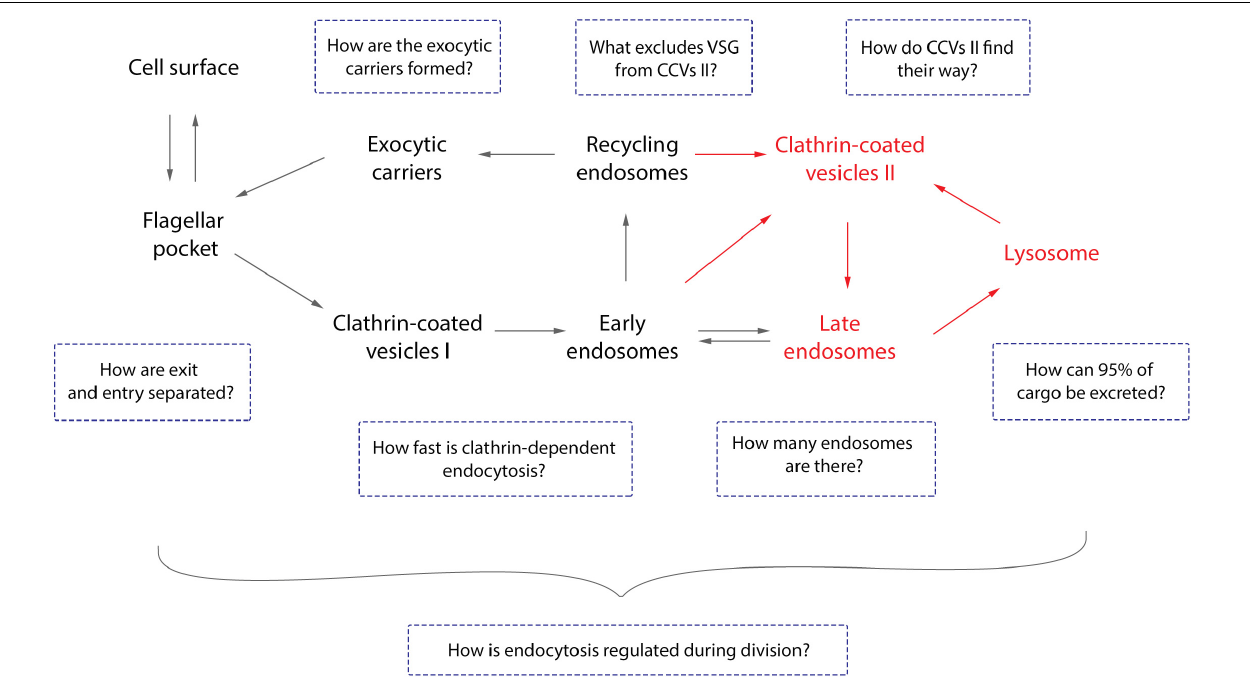
FIGURE 3 | Open questions about endocytosis of trypanosomes. The general route of endocytosis and recycling in Trypanosoma brucei is depicted. The gray arrows represent the direction of all cargo while the red arrows refer solely to fluid-phase cargo. Endo- and exocytosis is restricted to a single site in trypanosomes: the flagellar pocket. Thus, the first intriguing question is how does the cell discriminate between cargo entering and leaving the pocket? All molecules are endocytosed via clathrin mediated endocytosis (CME), the recycling rates are incredibly fast, and T. brucei lacks AP-2 (Grünfelder et al., 2002; Morgan et al.,